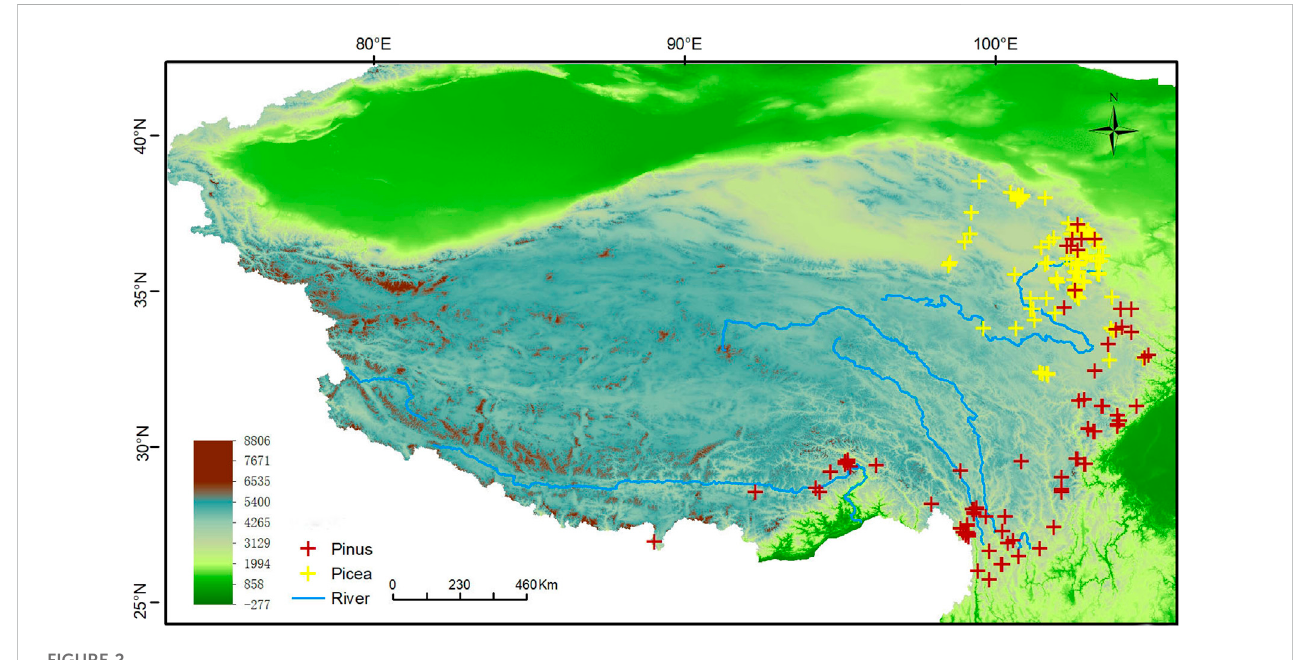
FIGURE 2 Localities of the sampling data.